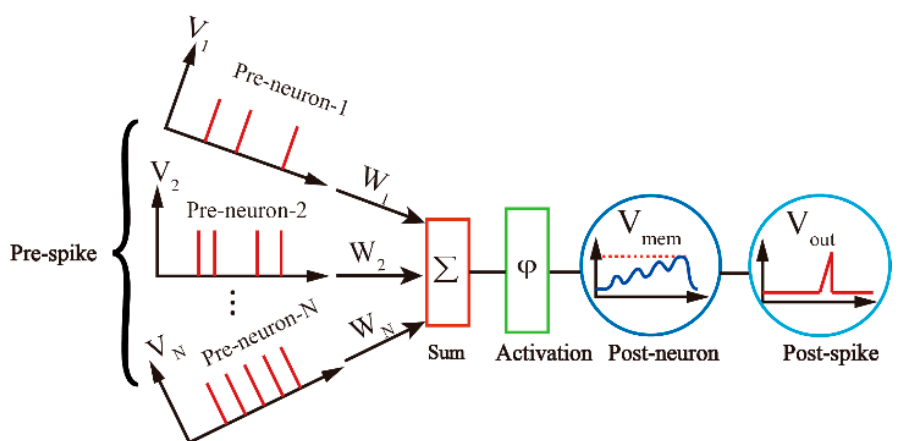
Figure 1. Illustration of a biological LIF neuron. A biological pre-neuron receives, processes, and transmits information to a post-neuron via a synapse.